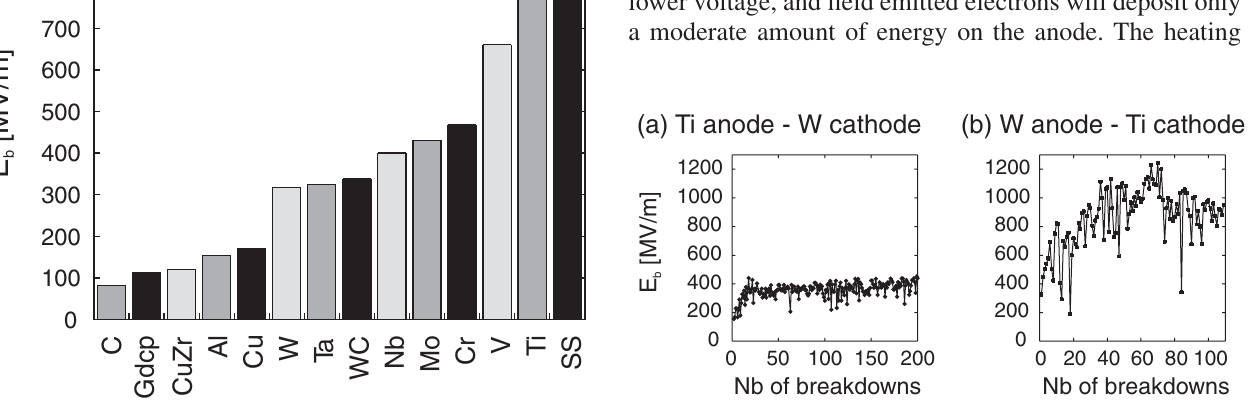
FIG. 6. Conditioning curves for: (a) Ti anode and W cathode; (b) W anode and Ti cathode.